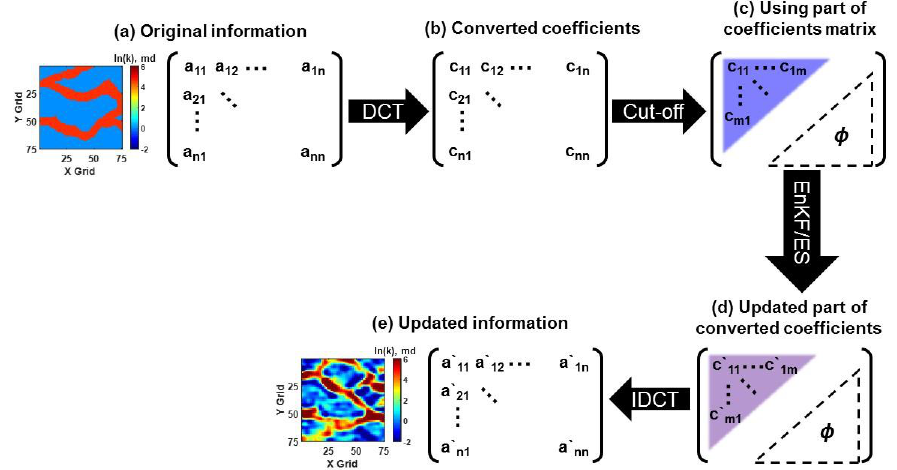
Figure 6. The workflow of ensemble-based method with DCT. ( a ) An ensemble member can be transformed to a matrix (original information); ( b ) The original information is converted to coefficients through DCT; ( c ) Only the low frequency area (upper left triangle) is used for assimilation by the ensemble-based method; ( d ) The coefficients in the low frequency area are updated; ( e ) The updated coefficients are inversely converted to the updated information. IDCT stands for inverse discrete cosine transform.